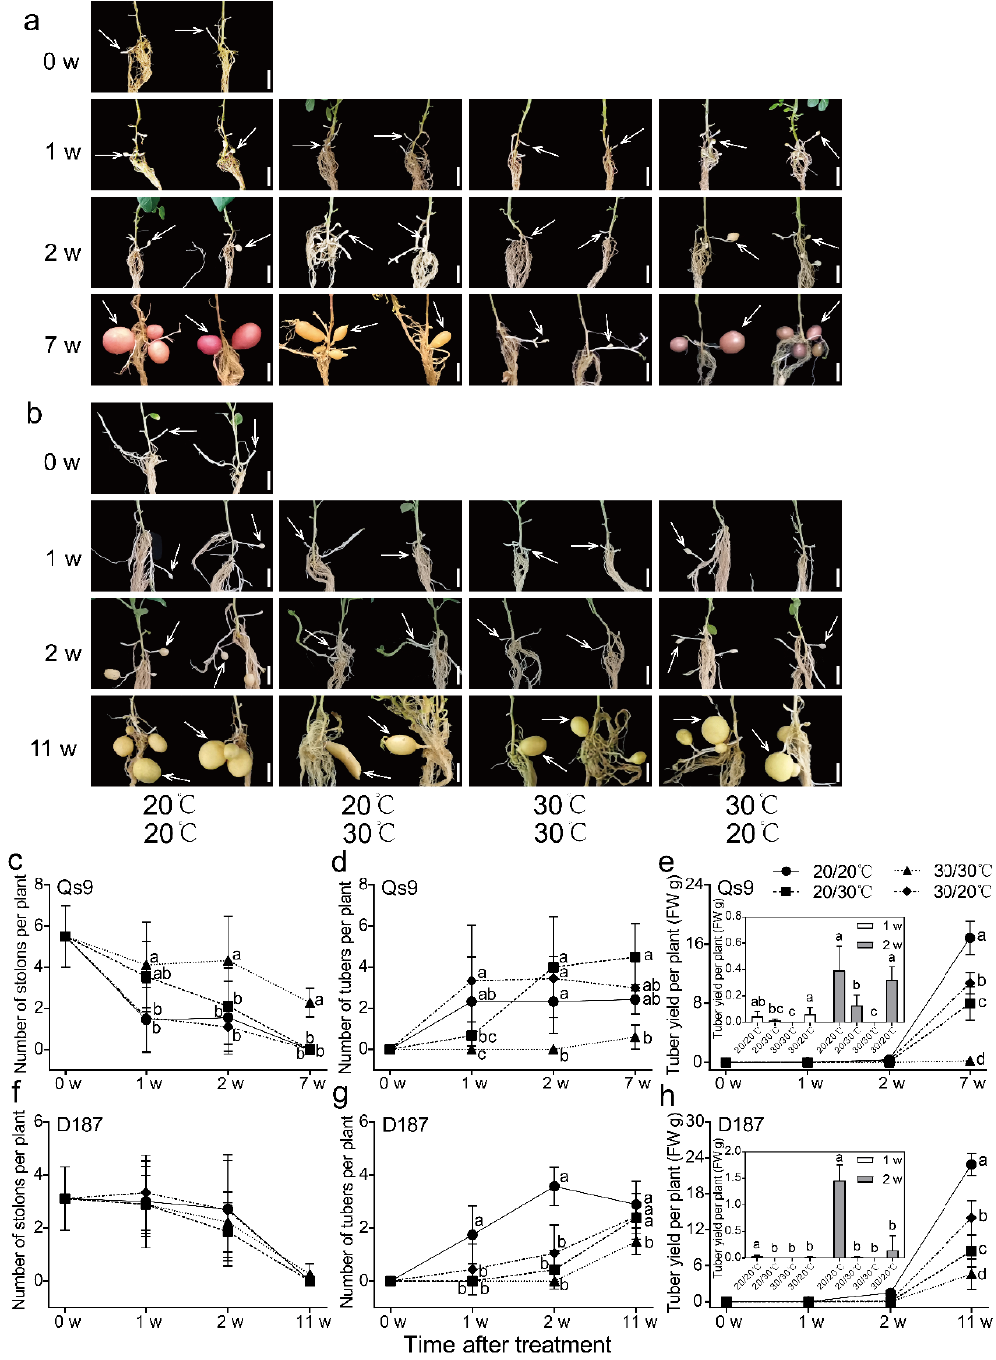
Figure 4. Potato tuberization of the Qs9 and D187 plants under the heat-stress treatment of different plant parts. Potato plants of the Qs9 ( a ) and D187 ( b ) cultivars were grown for 0, 1, 2, 7, or 11 weeks under heat-stress treatments of different parts of the plant. Photographs were taken after the removal of soil. Representative pictures among the nine replicates are displayed. Scale bars, 2 cm. The white arrow points to the tuber or stolon. w, weeks. ( c – e ): stolon number ( c ), tuber number ( d ), and tuber yield ( e ) per plant of the Qs9 cultivar at the indicated time points during the treatment. ( f – h ): stolon number ( f ), tuber number ( g ), and tuber yield ( h ) per plant of the D187 cultivar at the indicated time points during the treatment. Nine replicates were averaged and statistically analysed. ( e , h ) Graph inset showing an enlarged view of the tuber yield at 1 and 2 weeks. The different lowercase letters indicate groups that are significantly different from one